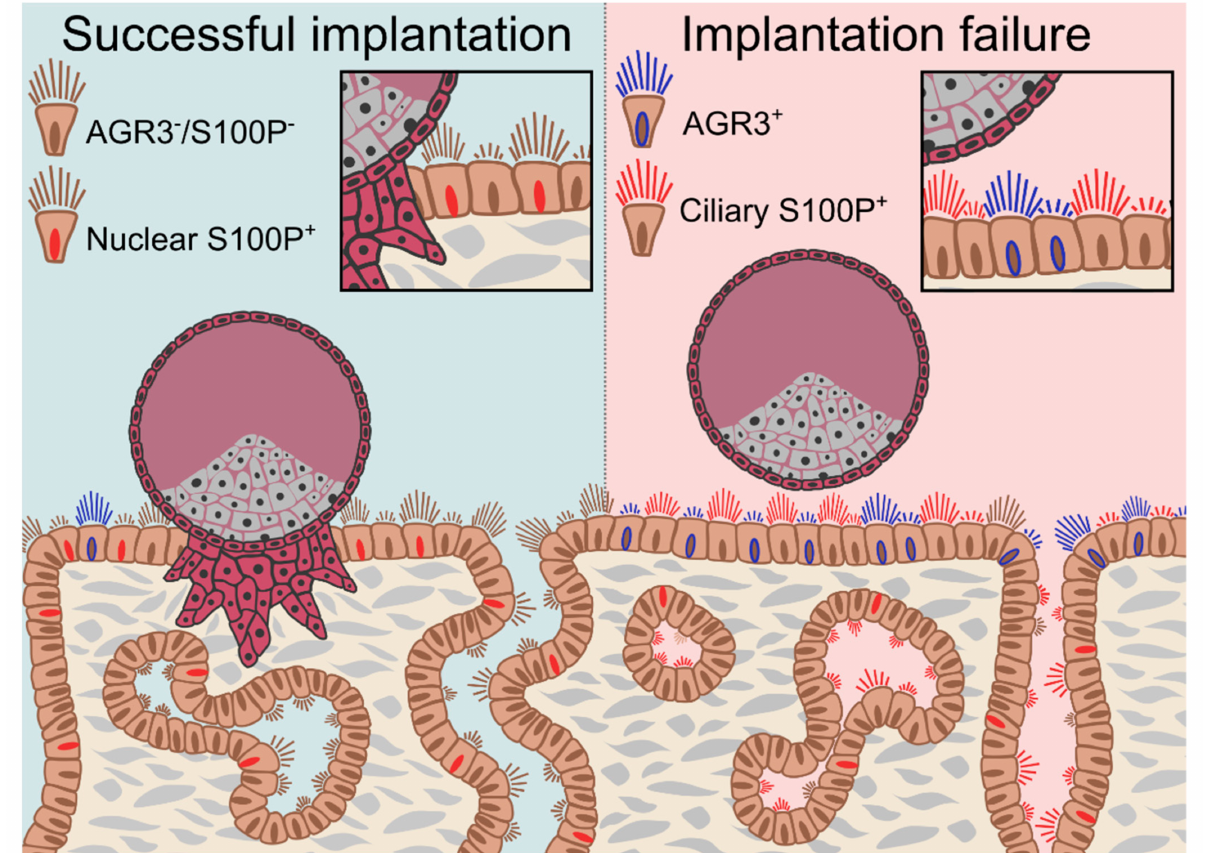
Figure 5. Differential AGR3 and S100P expression patterns are features of endometrial receptivity and may play a role in recurrent reproductive